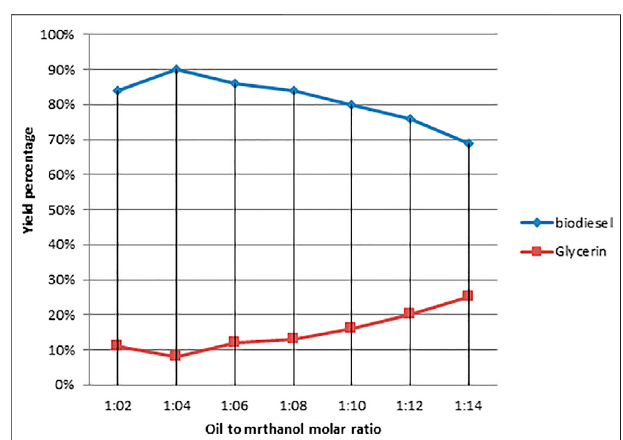
FIGURE 4 | Effect of variation in the molar ratio of oil to alcohol on biodiesel production